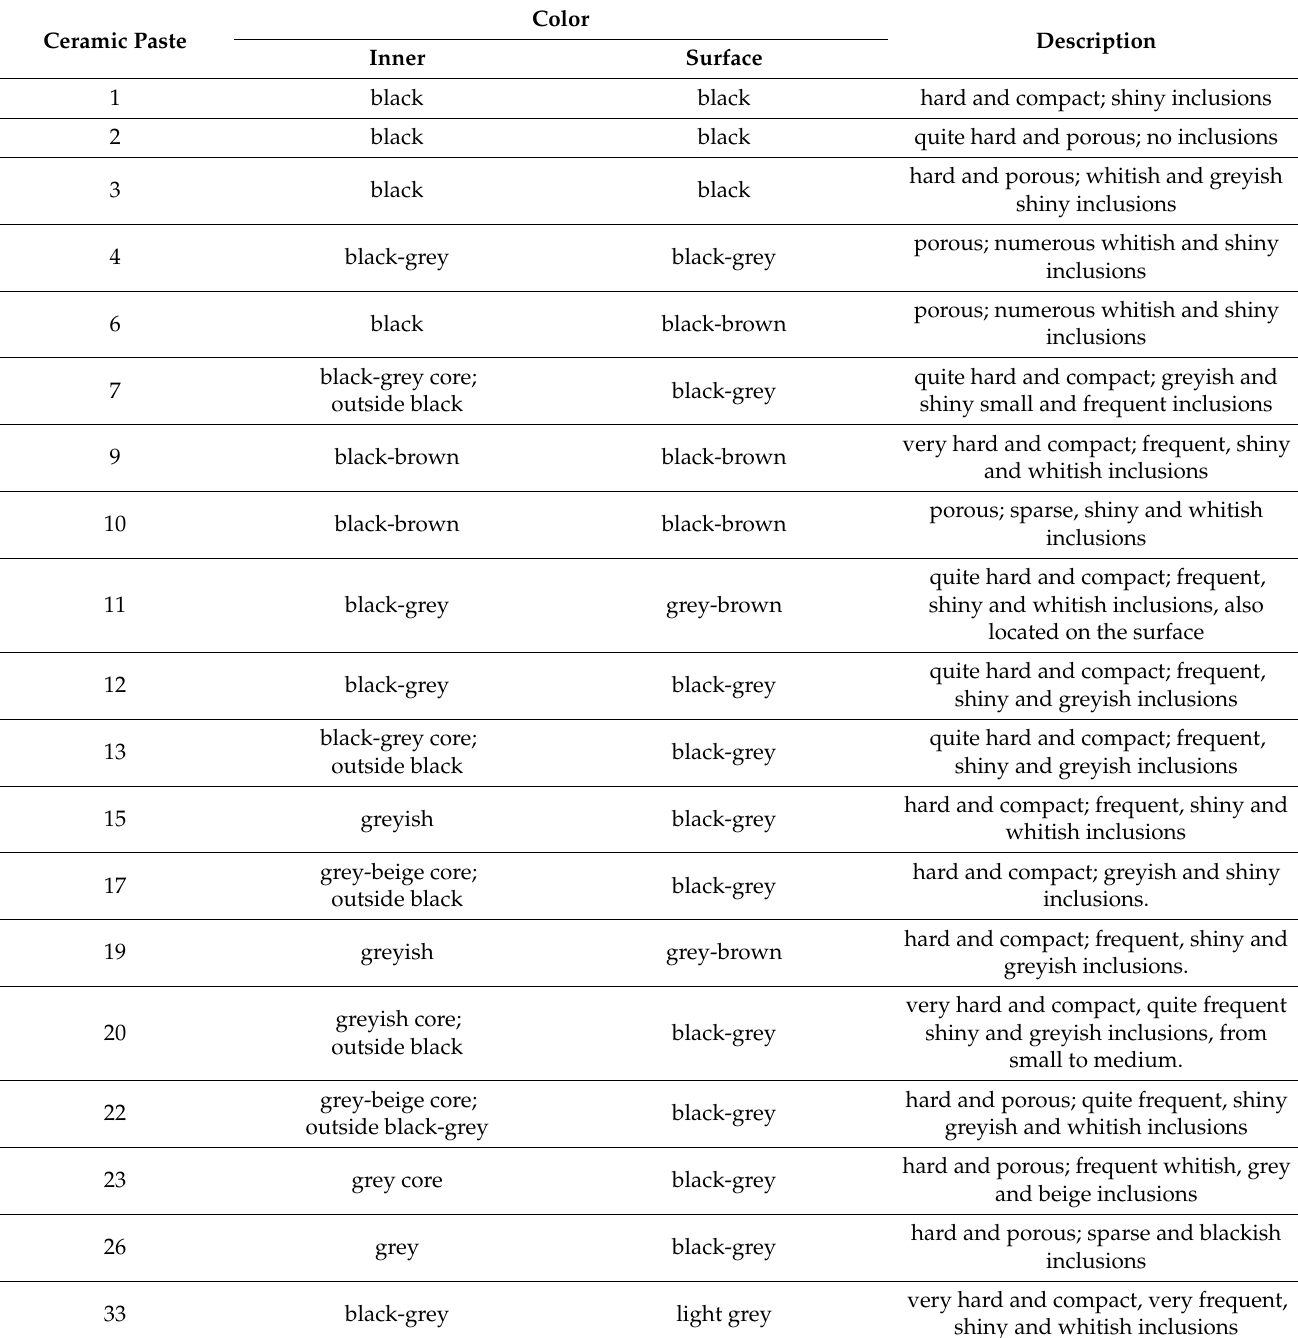
Table 2. Visual and tactile characteristics corresponding to each ceramic paste recognized for the bucchero from La Civita di